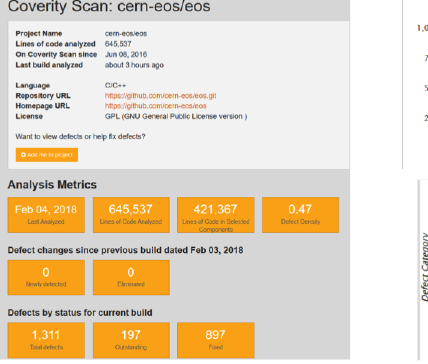
Figure 2. EOS Coverity details